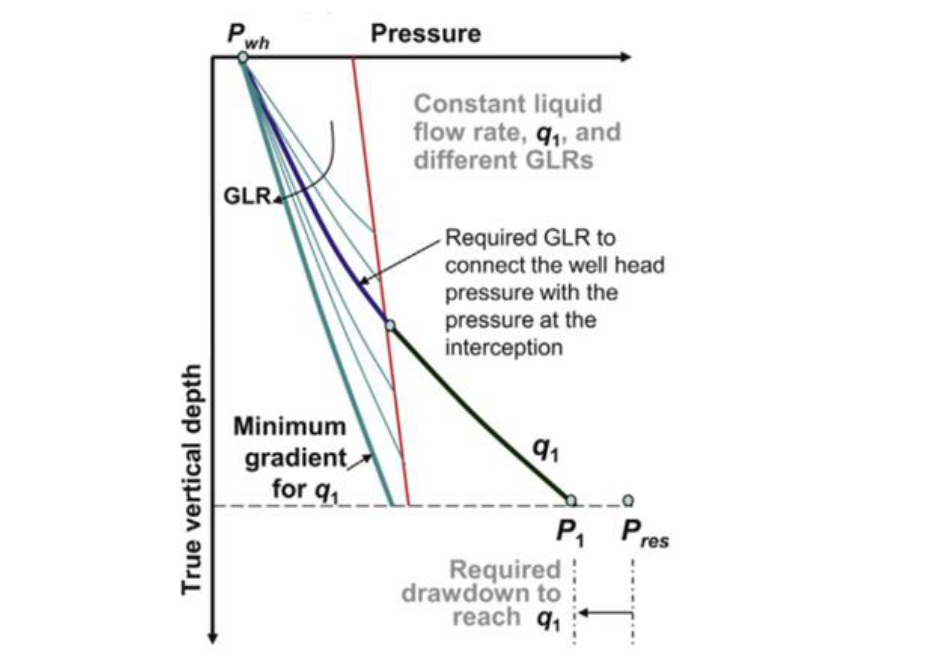
Table 3. Parameters of gas lift